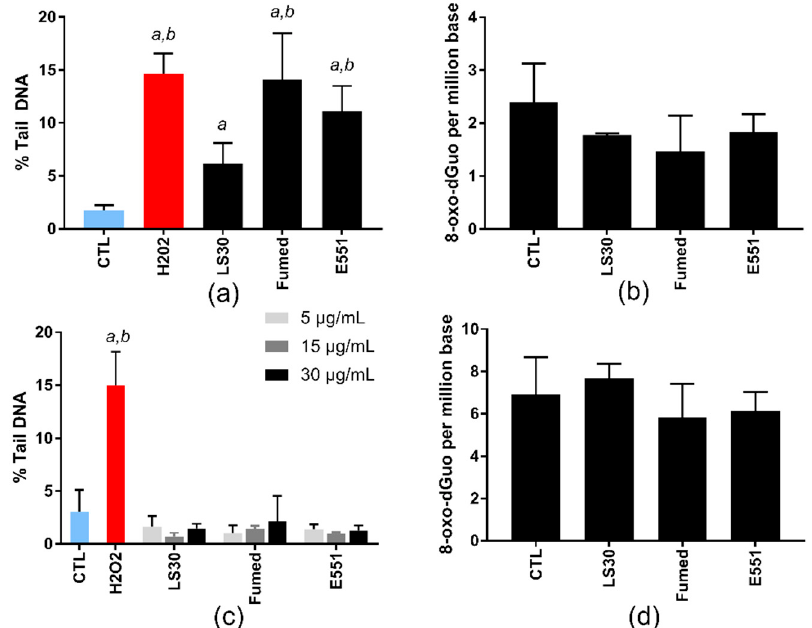
Figure 3. Genotoxicity of SiO 2 particles, acute exposure. ( a , c ) DNA strand breaks and / or alkali-labile sites, assessed via the alkaline comet assay, in RAW264.7 cells exposed to 10 µ g / mL SiO 2 ( a ) and in Caco-2 / HT29-MTX cells exposed to 5, 15, or 30 µ g / mL SiO 2 ( c ). H 2 O 2 (250 µ M) was used as positive control. Mean ± standard deviation of five independent experiments (n = 5); ( b , d ) quantification of 8-oxo-dGuo by high performance liquid chromatography-tandem mass spectrometry system (HPLC-MS / MS), in RAW264.7 cells exposed to 10 µ g / mL SiO 2 ( b ) and Caco-2 / HT29-MTX cells exposed to 50 µ g / mL SiO 2 ( d ). Mean ± standard deviation of three independent replicates from the same experiment (n = 3). Statistical significance, a p < 0.05, exposed vs. CTL (untreated cells), b p < 0.05, exposed vs. LS30.